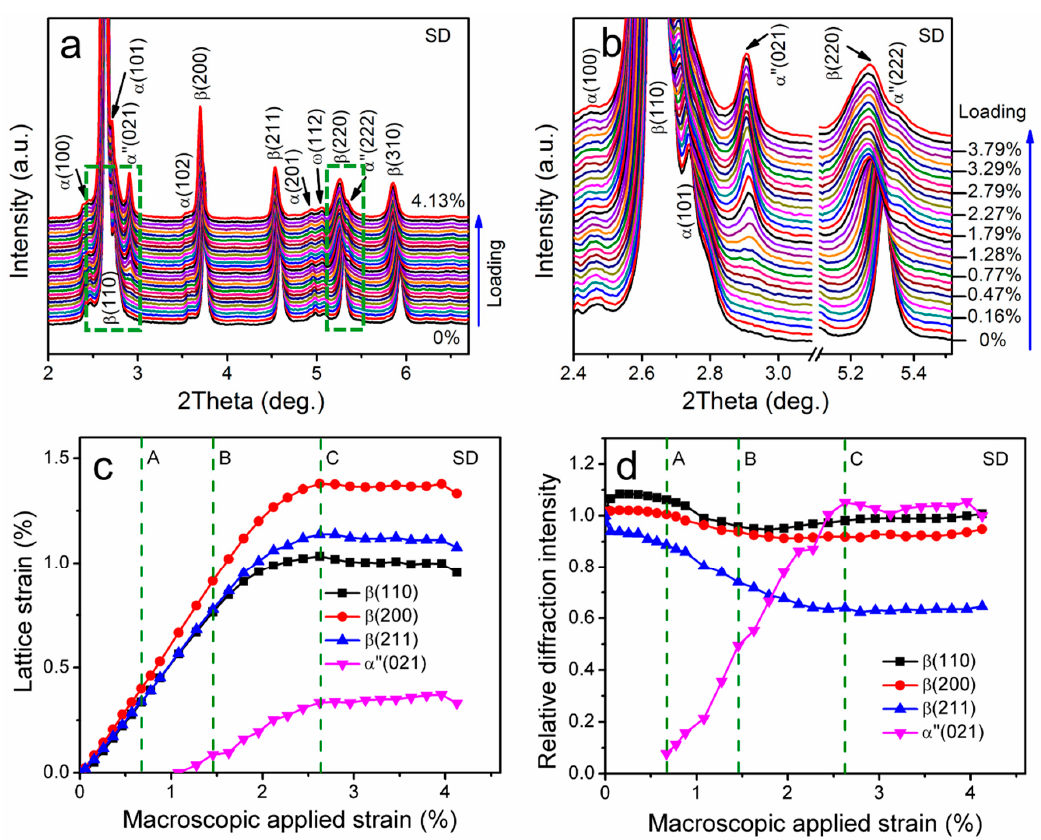
Figure 5. In situ SXRD analysis of the microstructural characteristics of the Ti36Nb5Zr alloy along SD. ( a ) One-dimensional SXRD spectrums. ( b ) Enlarged views of the boxed areas in ( a ). Evolution of the ( c ) lattice strains and ( d ) relative integrated diffraction peak intensities of the (110) β , (200) β , (211) β and (021) α ” crystal planes as functions of the macroscopic applied strain. A, B and C in ( c ) and ( d ) represent